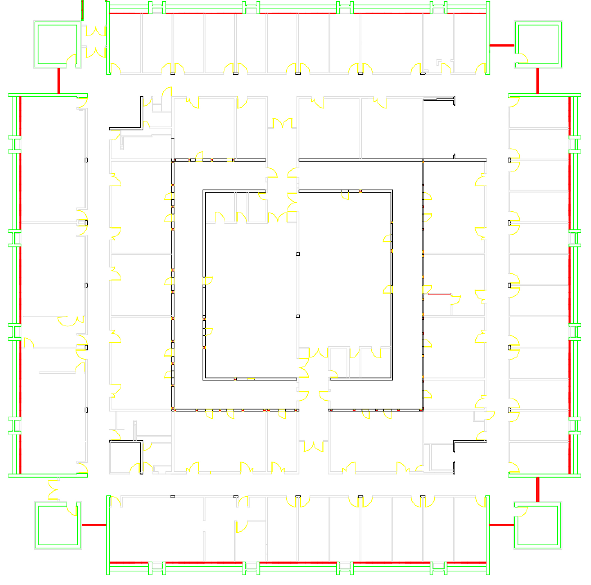
Figure 1. CAD model of the floor plan